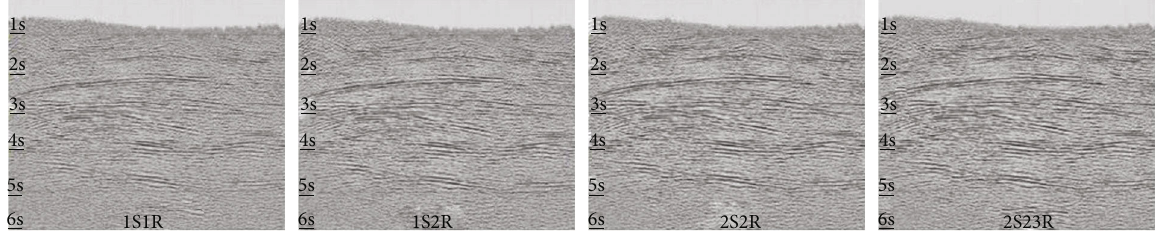
Figure 10: Preliminary stack sections with di ff erent geometry